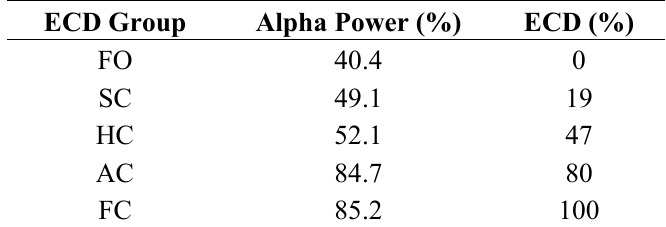
Table 2. Collected observed ECD and Alpha power percentage from one subject.